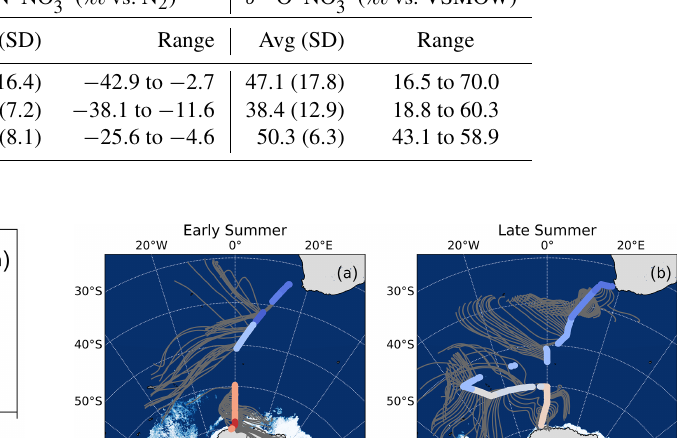
Table 1. The average (avg), standard deviation (SD) and range of total coarse-mode ( > 1µm) atmospheric nitrate concentration ([NO ngm − 3 ) and the mass-weighted average N and O isotopic composition of coarse-mode nitrate ( δ 15 N–NO − Cruise legs are denoted as follows: early summer (ES), Weddell Sea (WS) and late summer (LS). Leg [NO − ] (ngm − 3 ) 3